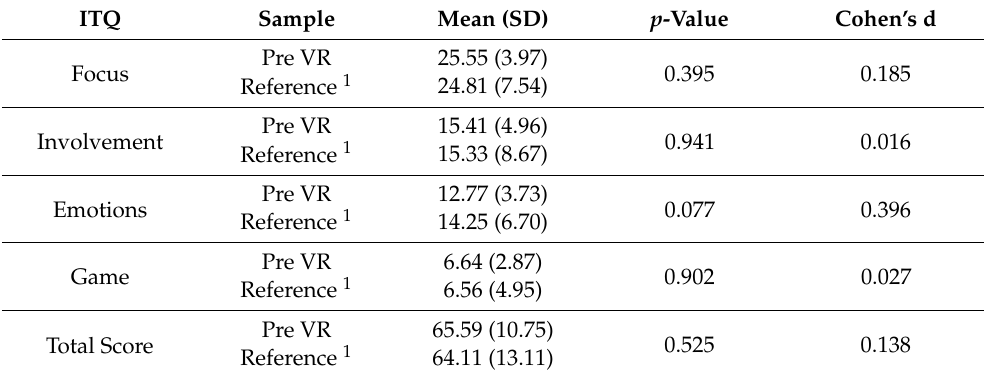
Table 2. Results of the immersive tendencies questionnaire (ITQ) and a reference sample from the